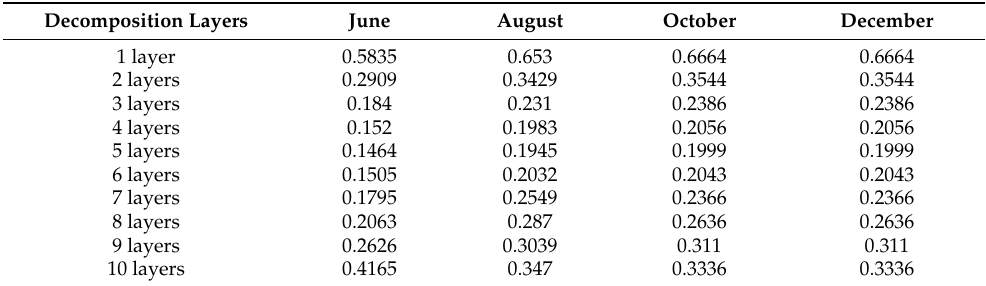
Table 4. Comprehensive scores of wavelet denoising with different decomposition layers.